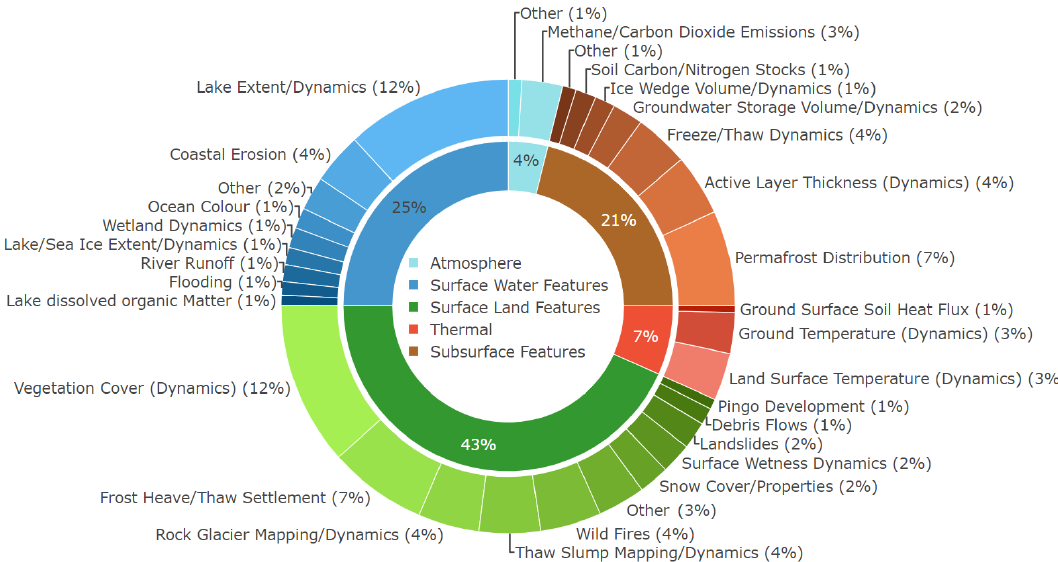
Figure 7. Distribution of the study focus frequency across the reviewed articles. Research foci are categorized into the five spheres “Atmospheric Features and Processes”, “Surface Water Features and Processes”, “Surface Land Features and Processes”, “Thermal Features and Processes” and “Subsurface Features and